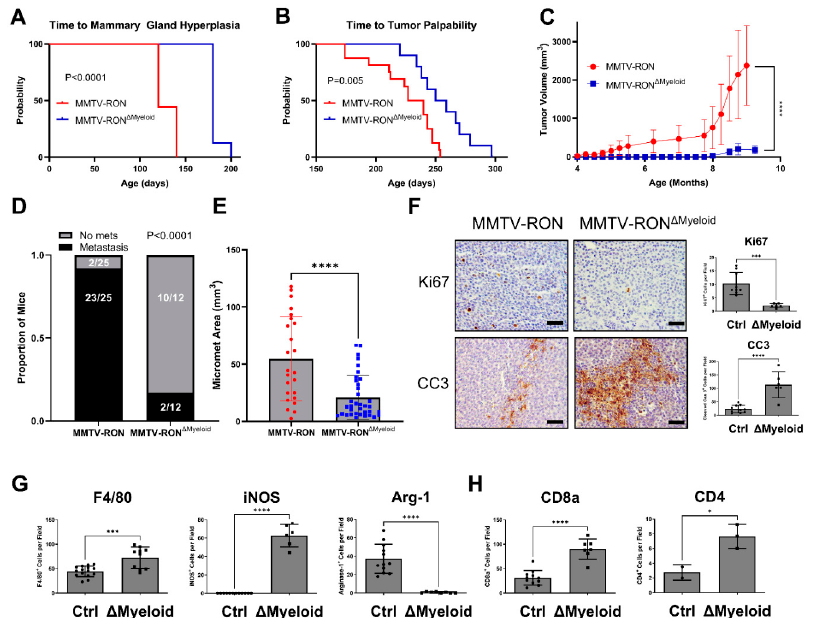
Figure 2. Conditional RON deletion in the myeloid compartment phenocopies global HGFL loss in a RON-driven mammary tumorigenesis model. Kaplan-Meier analysis with Log-Rank statistics of mice for ( A ) time to onset of mammary ductal hyperplasia (MMTV-RON, n = 9; Δ Myeloid, n = 8) and ( B ) time to tumor palpability of MMTV-RON+ mice with or without conditional deletion of RON in the myeloid compartment ( Δ Myeloid; MMTV-RON, n = 16; Δ Myeloid, n = 10). ( C ) Tumor growth kinetics of MMTV-RON+ or MMTV-RON Δ Myeloid mice (MMTV-RON, n = 9; Δ Myeloid, n = 9) and ( D ) respective gross metastatic incidence at 90 days of age. ( E ) Micro-metastatic area meas- ured on H&E stained sections from mice of both genotypes taken from mammary tumors with com- parable tumor volume (MMTV-RON, n = 6; Δ Myeloid, n = 5). ( F ) Quantitated histological analysis of MMTV-RON and Δ Myeloid mammary tumor sections stained with Ki67, CC3, ( G ) F4/80, iNOS, Arginase-1, ( H ) CD8a, or CD4. Comparisons of histological samples between groups were analyzed using Student’s t -tests. * p < 0.05; *** p < 0.001; **** p < 0.0001. 3.3. Tumor Cell-Secreted and Physiologic Sources of HGFL Each Support Mammary Tumor Growth The use of conditional RON deletion models has provided valuable insight into cell- type-specific responses to HGFL and ensuing effects on mammary tumor growth. Further, HGFL global deletion demonstrated the pro-tumorigenic role of HGFL-mediated RON activation [5]. However, the pro-tumorigenic potential of individual sources of HGFL (physiologic versus tumor cell-produced) has not been evaluated. To test this, we em- ployed the murine R7 breast cancer cell line which expresses both RON and HGFL [4,7]. The R7 cells were modified with a non-targeting and HGFL targeting shRNA to generate isogenic R7 cell lines with (R7 shNT) and without HGFL (R7 shHGFL) (Figure 3A). Next, we performed syngeneic orthotopic mammary gland transplantation studies whereby R7 control (shNT) and R7 shHGFL cells were placed into the mammary glands of either wild- type (WT) or HGFL deficient (HGFL − / − ) syngeneic hosts. Control R7 shNT cells efficiently